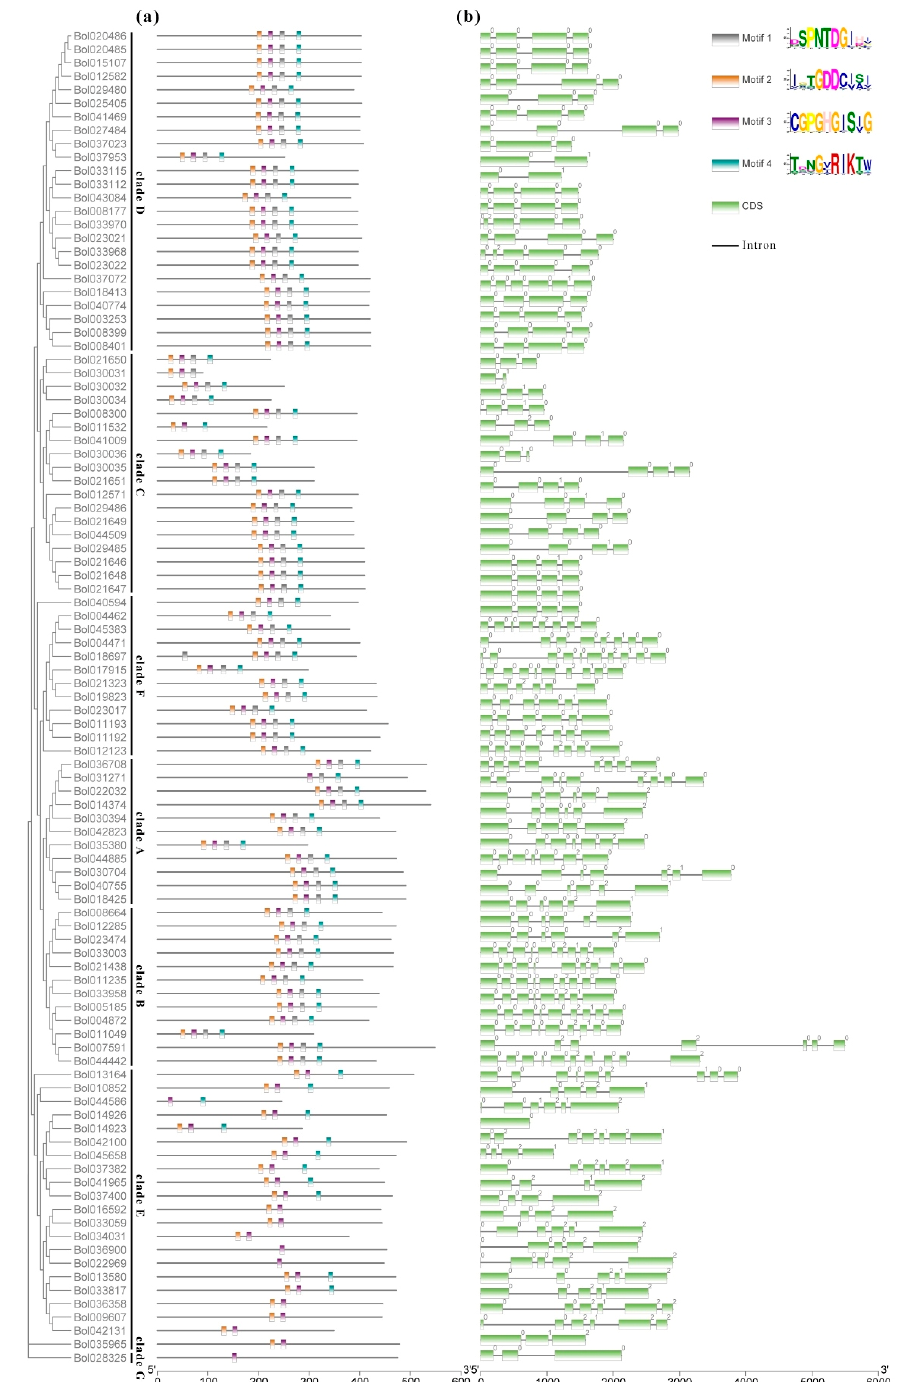
Figure 2. Analysis of the conserved motifs and gene structures of Brassica oleracea PGs (BoPGs). ( a ) Four motifs of PG genes were investigated by the online tool MEME. Motif I to motif IV (I, SPNTDGI; II, GDDC; III, CGPGHGIS; and IV, RIK) are indicated by di ff erent color boxes, respectively. ( b ) Exon and intron organization of PG genes. Exons and introns are represented by green boxes and black lines, respectively. Intron phases are also analyzed from the exon information. Phase 0 is designated as introns between codons, phase 1 is designated as introns between the first and the second nucleotide in a codon, and phase 2 is designated as introns between the second and third nucleotides in a